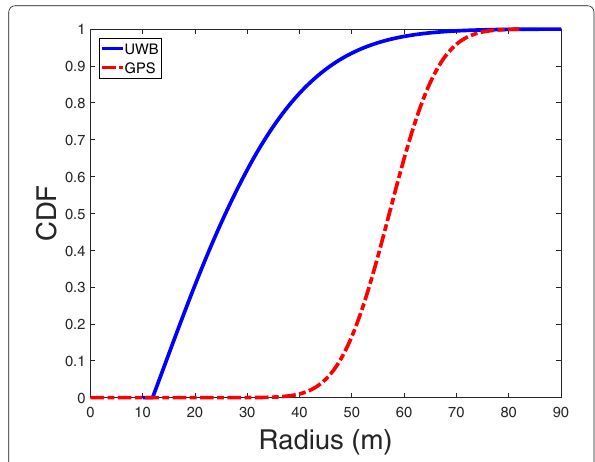
Fig. 17 CDF of the hotspots radius depending on the localization method. This figure represents the CDF of the radius where the hotspots radius are in general smaller using UWB than using GPS